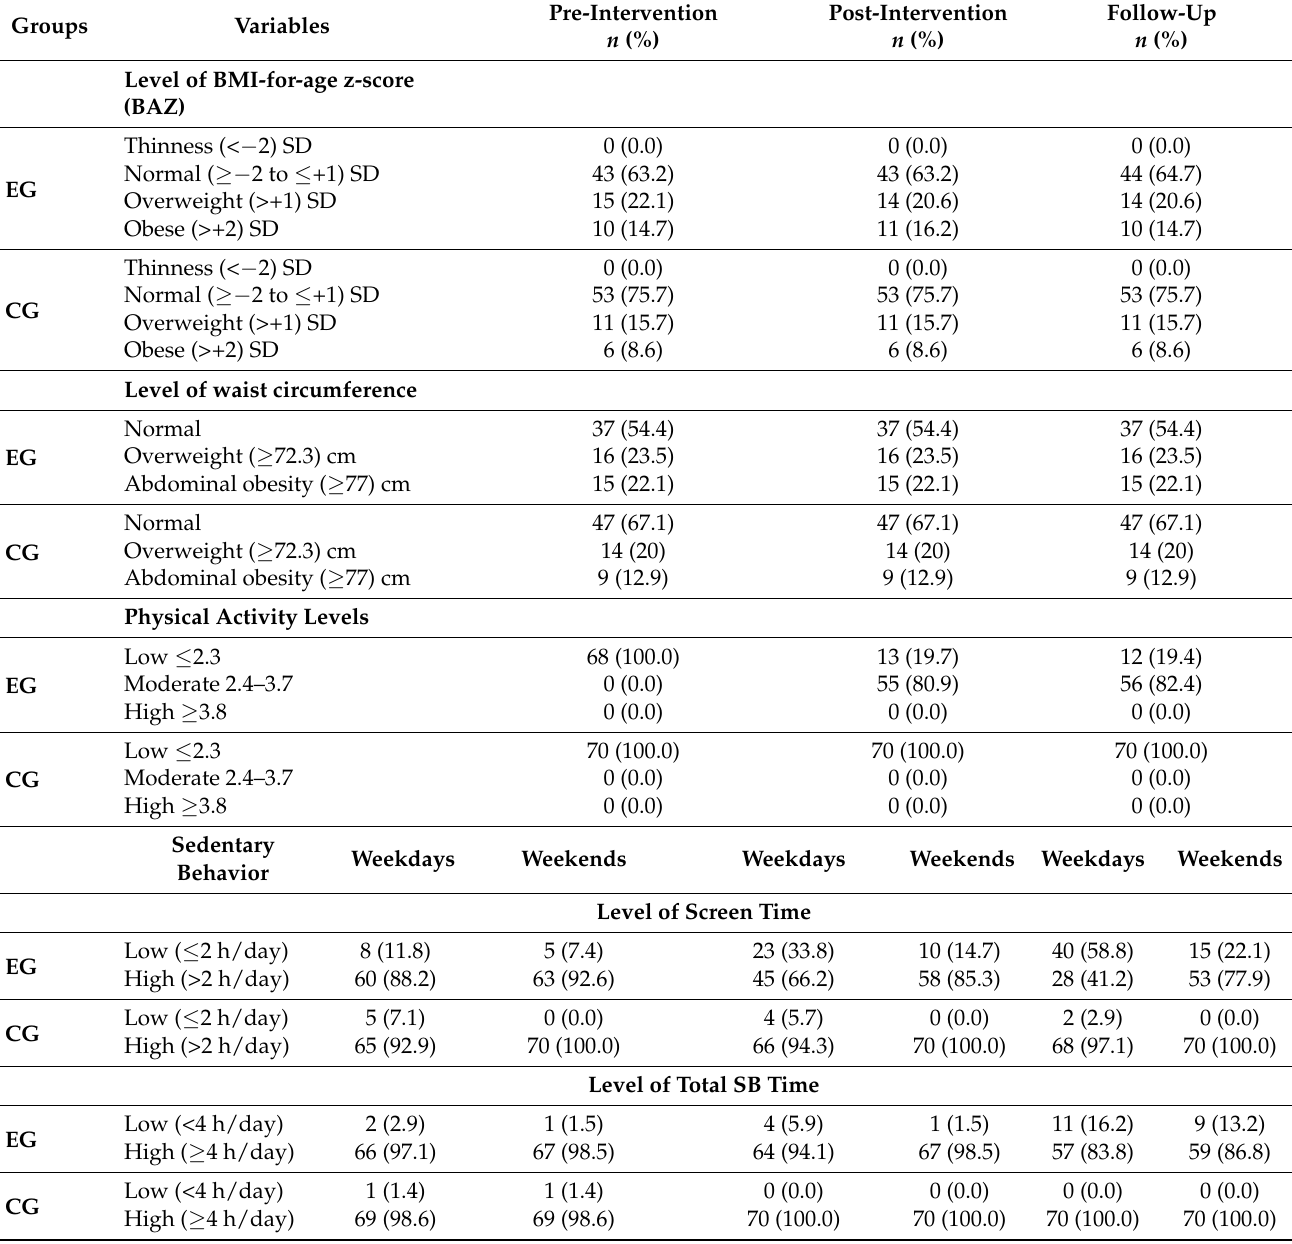
Table 1. Descriptive Statistics of BMI-for-age z-score, waist circumference, physical activity and screen time and the total sedentary behavior on weekdays and weekends for both groups over